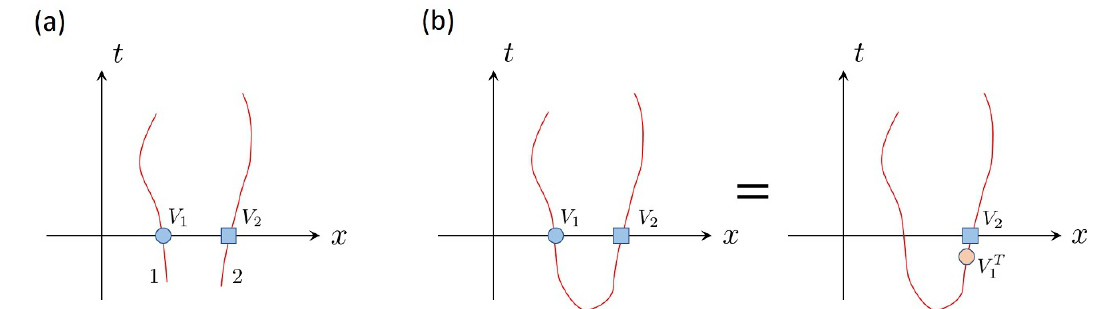
Figure 1 . (a) The world lines of two spin- 1 particles 1 ; 2 in spacetime (red curves). Two operators 2 V 1 and V 2 probe the spins of the two particles at time t = 0. (b) When the initial state of the spins of the two particles forms an EPR pair, the e(cid:11)ect of V 1 (cid:10) V 2 on particles 1 and 2 is equivalent to applying V 2 V T to particle 2 1